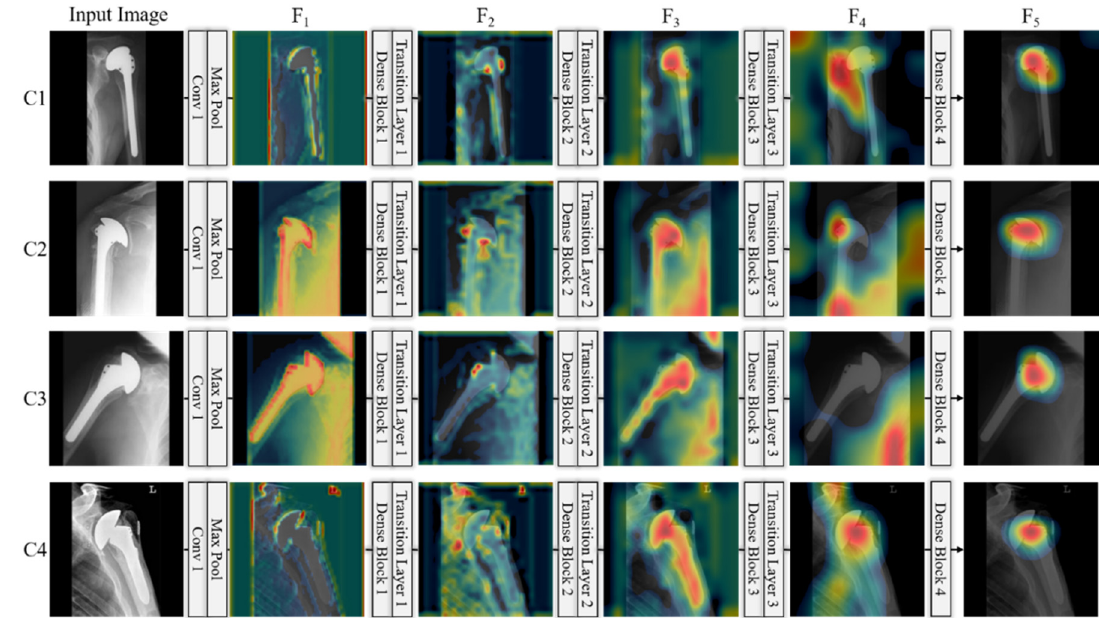
Figure 13. Class activation maps for given inputs of four classes (C1–C4), which are extracted from modified DenseNet-201 of Table 3. C1–C4 indicate the classes of four manufacturers, Cofield, Depuy, Tornier, and Zimmer, respectively.